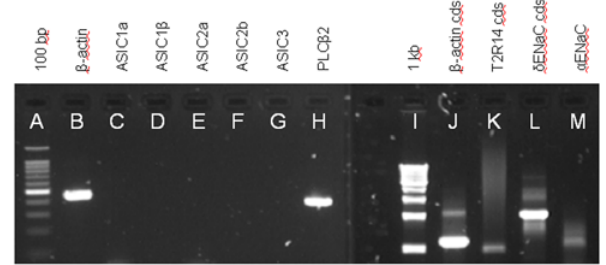
Figure 3. RT-PCR analysis of gene expression for sour-ageusic Patient 8716. The patient expresses transcripts for housekeeping genes and those involved in sweet, bitter and salty taste, but ASIC transcripts are undetectable even after 50 cycles of amplification. Lane identifications: (A) 100 bp DNA marker with the brightest band being 500 bp; (B) Transcript for 460-bp fragment of b -actin; (C–G) Transcripts for, respectively, ASICs 1a, 1 b , 2a, 2b and 3; (H) Transcript for PLC- b 2, which is involved in the transduction pathways of sweet and bitter; (I) 1 kb DNA marker; (J) full coding sequence of b -actin; (K) full coding sequence of bitter receptor T2R14; (L) full coding sequence of d -ENaC; and (M) partial coding sequence of a -ENaC. RT-PCR was performed with cDNA from fungiform papillae but only the data for the tubes containing reverse transcriptase are presented. No products were detected in the tubes lacking reverse transcriptase. Individual amplification reactions were performed for each named molecular target and the data are shown in collated form. Identities of all amplification products were confirmed by sequencing.